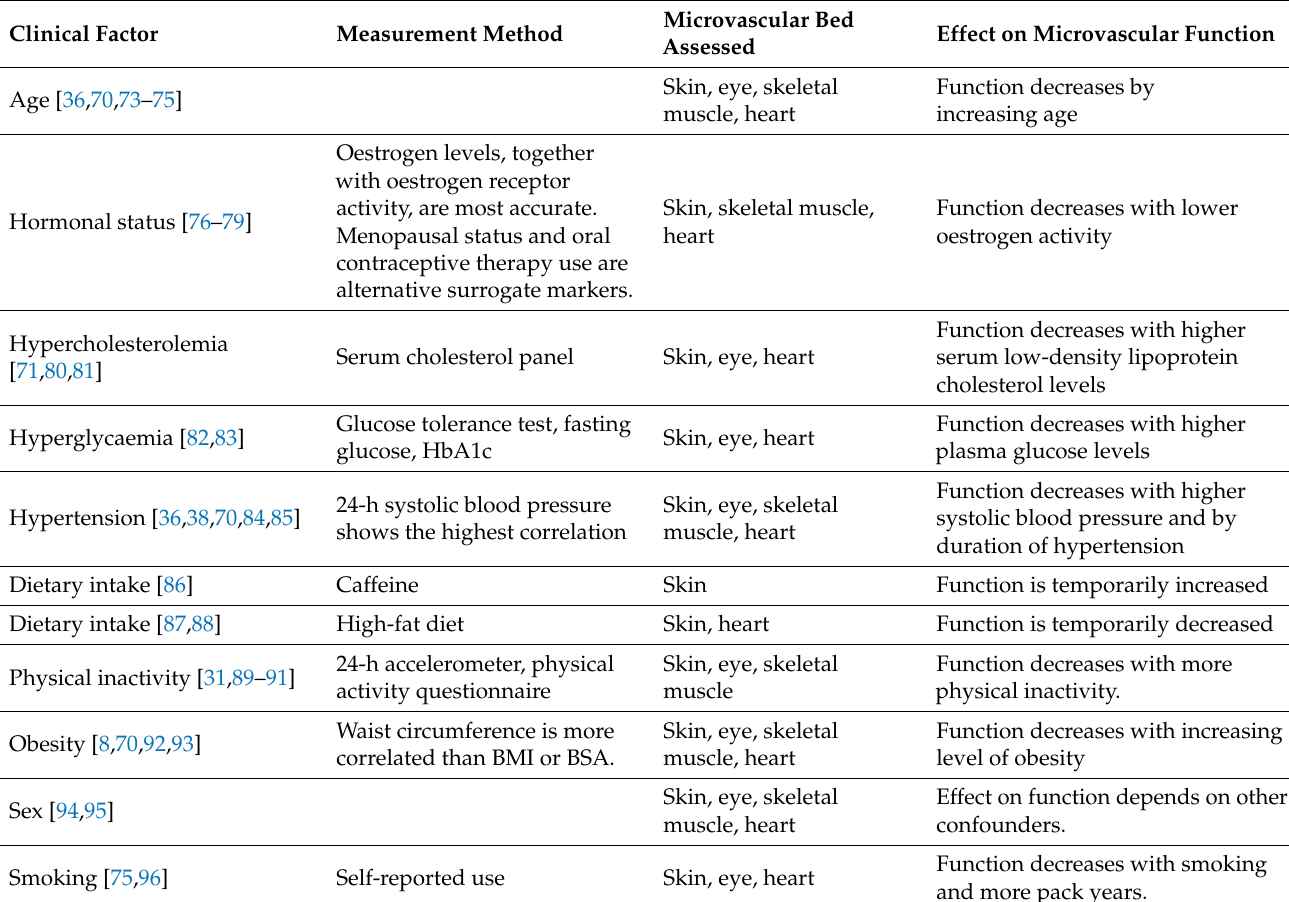
Table 3. Clinical factors associated with microvascular